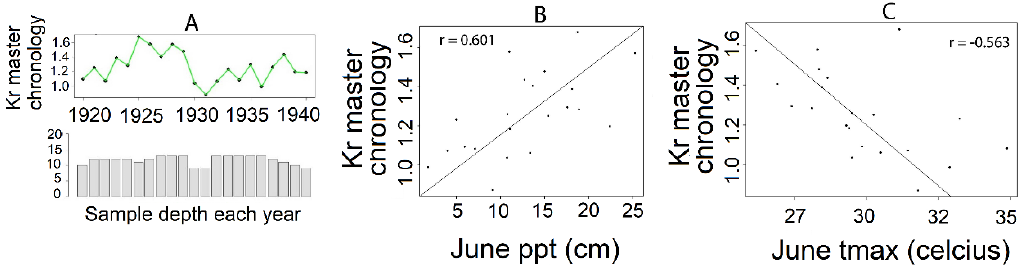
Figure 4. Selection of the climatic variable to detrend the age-detrended potential hydraulic conductivity (Kr) chronology (average of all the time-series, “Kr master chronology”), corresponding to the years 1920–1940, which had the highest sample depth for the period of 1895–1969. Abbreviations for climatic variables are as follows; ppt = sum precipitation in cm for each month, tmax = average maximum daily temperature for a given month in a year. June ppt had the highest magnitude of correlation with the Kr master chronology ( r = 0.601, p < 0.001). The subsequent “age and climate” detrended time-series was detrended by the predicted relationship between each of the 14 time-series for Kr and June ppt.